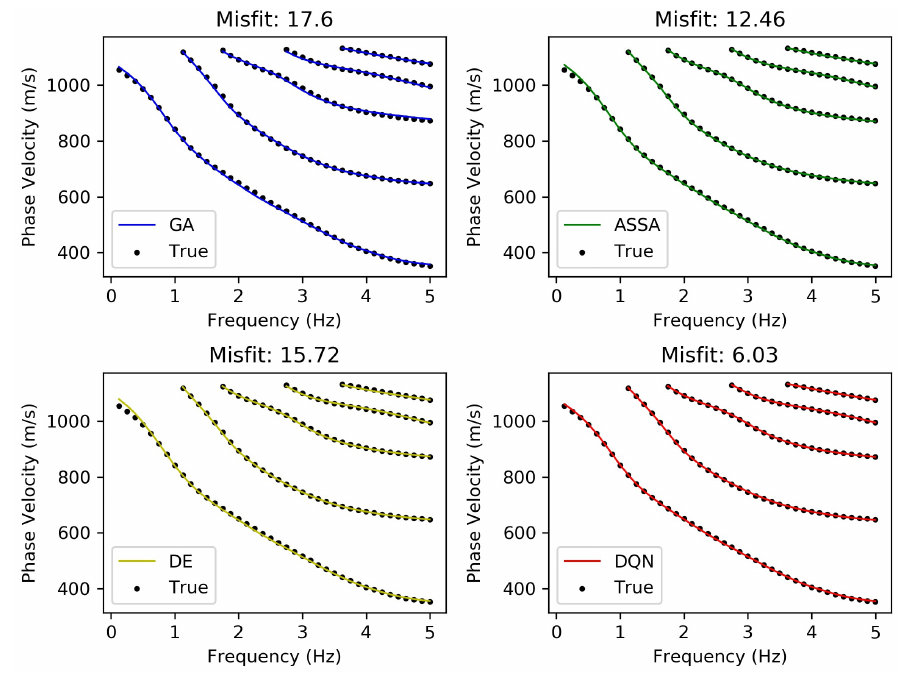
Figure 3. The estimated dispersion curves with the ground truth in Case 1. The estimated shear wave velocity profiles with the ground truth are shown in Figure 4, where the black line refers to the ground truth. The blue, green, yellow, and red lines express the estimated shear wave velocity profiles by the GA, ASSA, DE, and DQN framework,